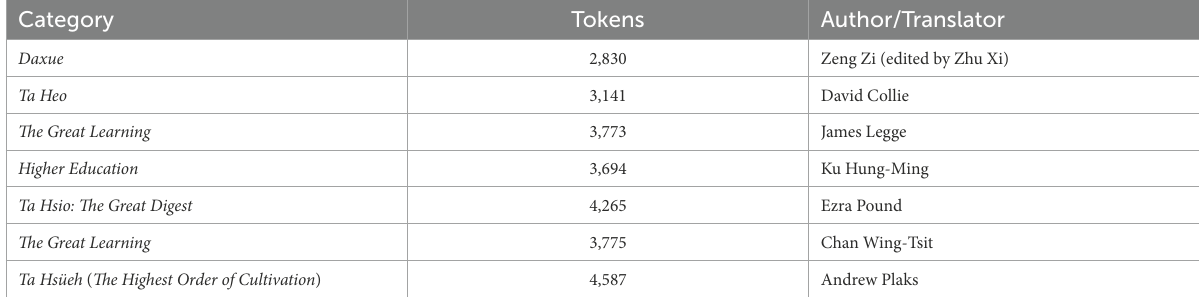
TABLE 2 Description of the corpus in the current